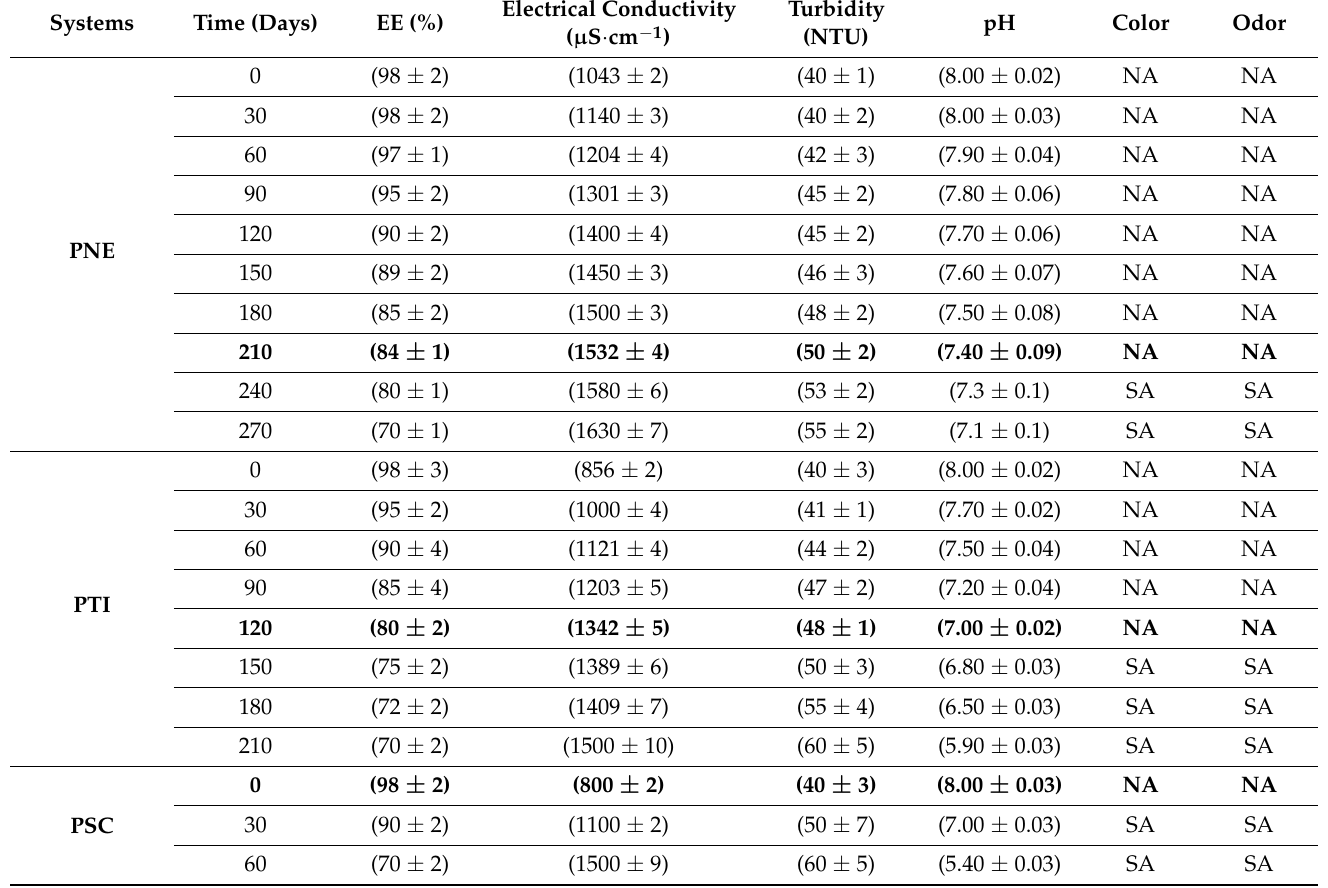
Table 3. Shelf-life stability of the PNE, PTI, and PSC systems at 25 ◦ C evaluated every 30